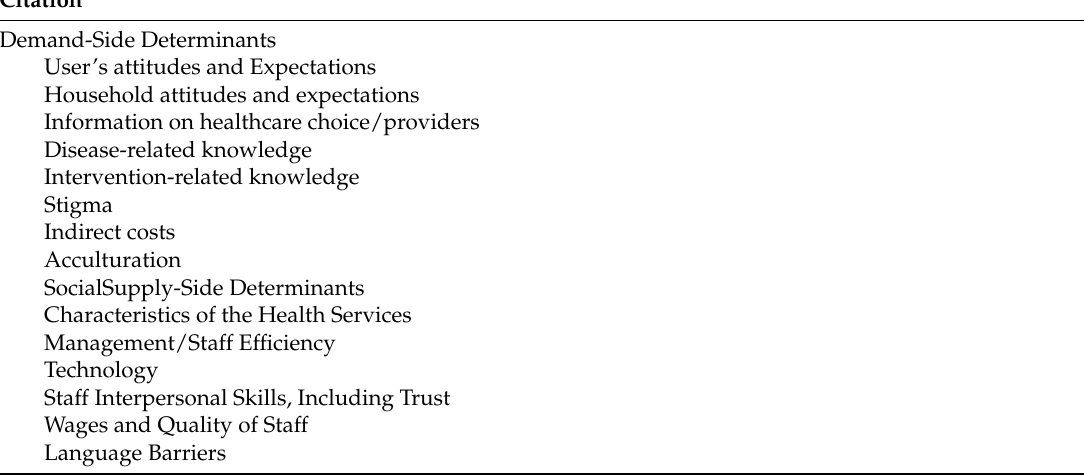
Table A2. Acceptability.